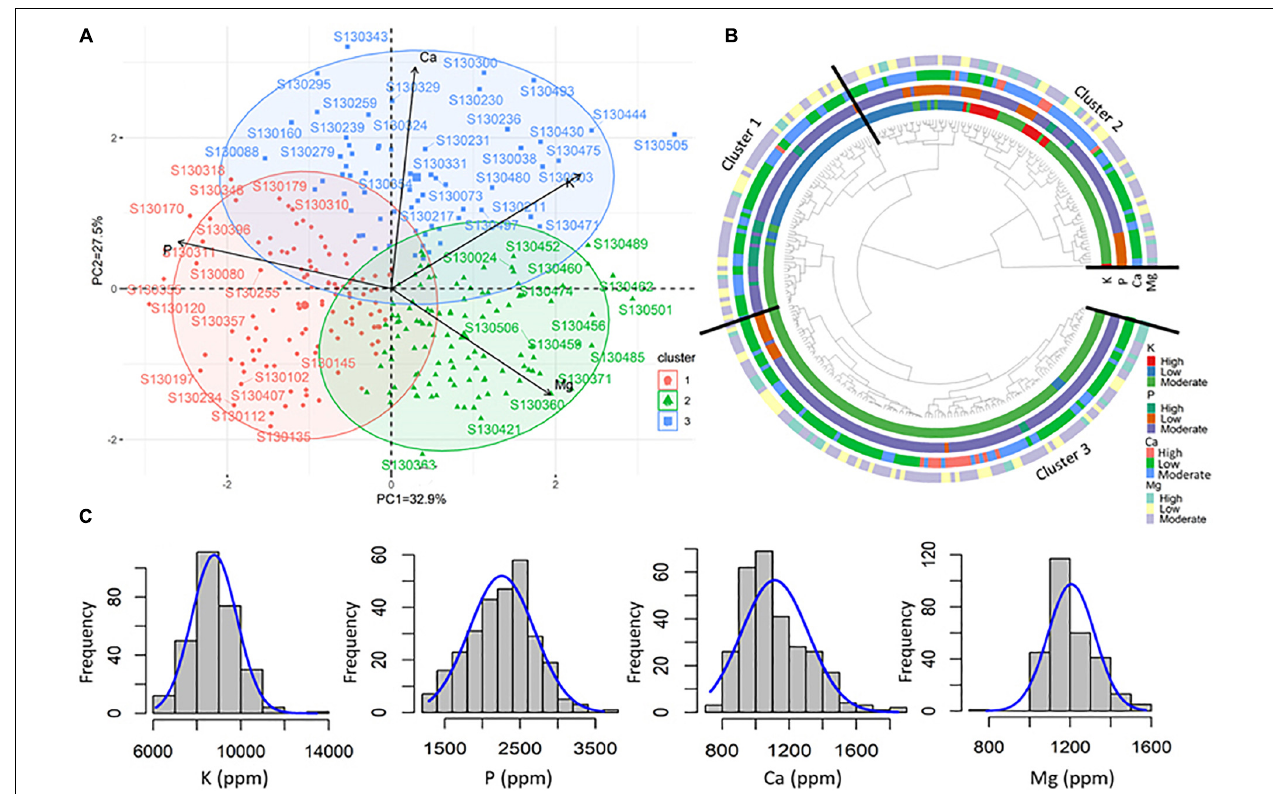
FIGURE 5 | (A) Biplot of the first two dimensions of the PCA. (B) Dendrogram showing the list of genotypes grouped in each cluster with the level of major macronutrients. (C) Normal distribution and frequency different tested genotypes and their contents in potassium (K), phosphorus (P), calcium (Ca), and magnesium